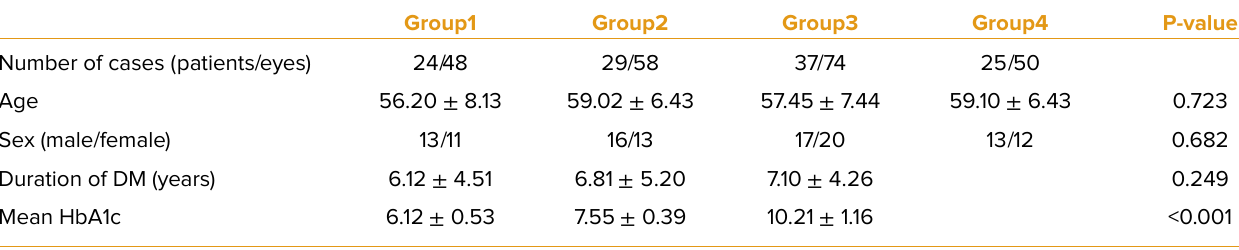
Table 1. Demographic data of subjects in all study groups